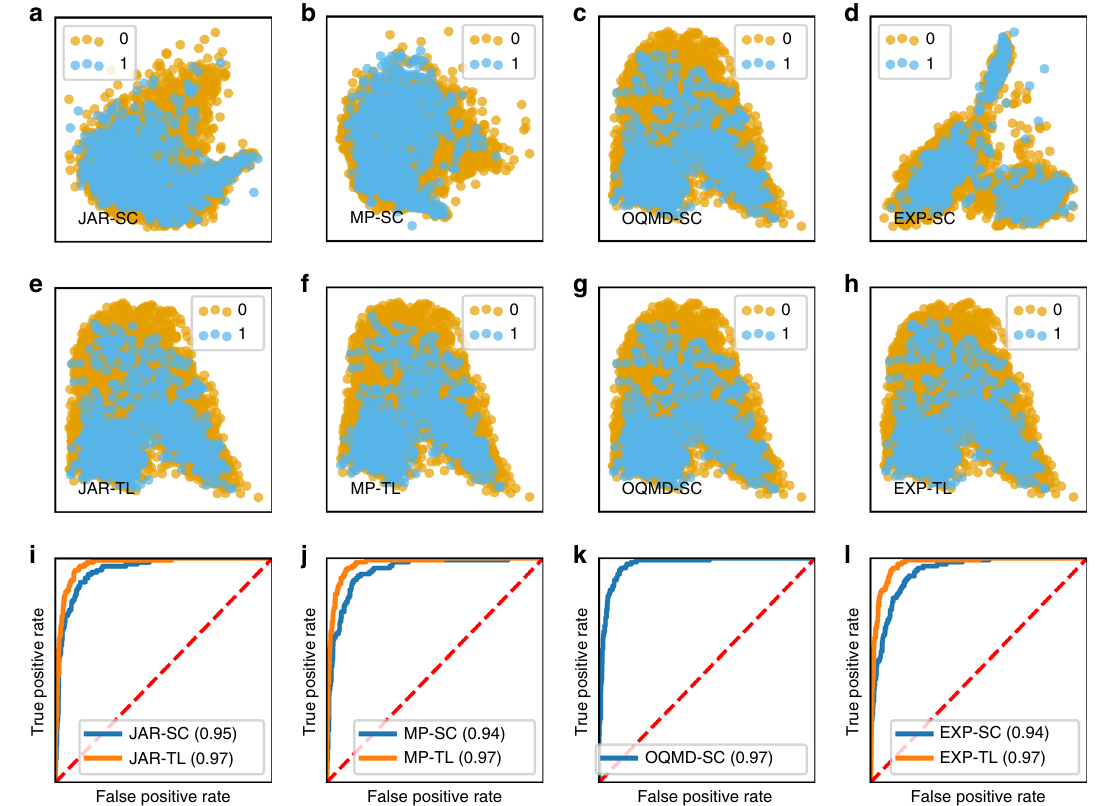
Fig. 6 Activation analysis to understand the impact of transfer learning. Here, we analyze the activations from the fi rst hidden layer of the ElemNet architecture for understanding the impact of transfer learning on the model ’ s capability to automatically learn to distinguish between the magnetic vs non- magnetic class (1 and 0) from JARVIS data set. The four columns represent the models trained using four different data sets: a , e , and i using JARVIS (JAR), b , f , and j using Materials Project (MP), c , g , and k using OQMD and d , h , and l using the experimental observations (EXP); the fi rst a – d and second e – h (except g) rows represent scatter plots demonstrating the fi rst two principal components of the activations using principal component analysis (PCA) technique from the models trained from scratch (SC) and using transfer learning (TL), whereas third row i – l represents the ROC curves from the Logistic Regression model trained using complete set of activations from the same hidden layer (the corresponding AUC values are shown in brackets) on the corresponding data